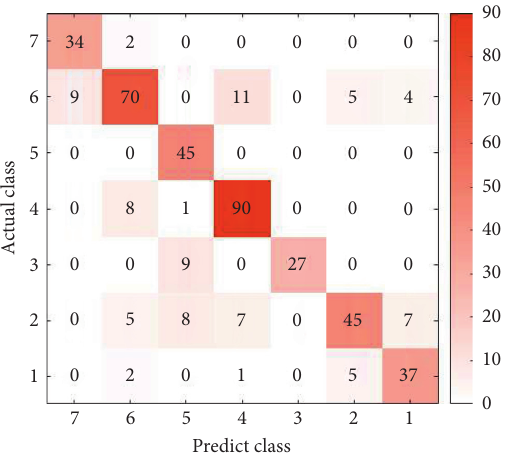
Figure 16: Confusion matrix of ERN18 for the training